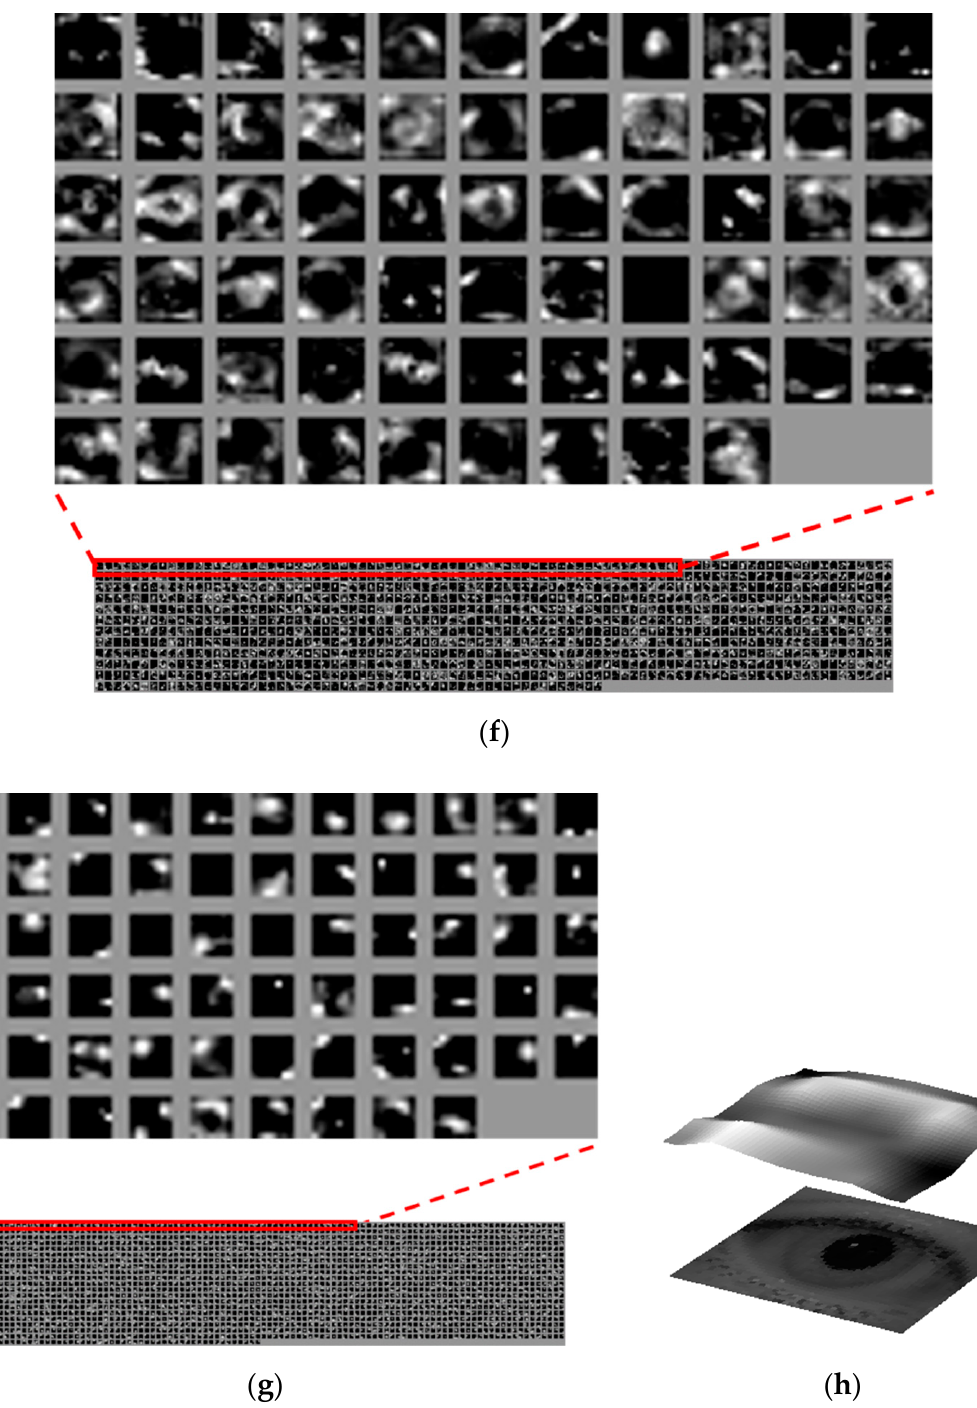
Figure 12. Examples of features maps extracted from each layer for the input ocular images. Feature maps from ( a ) Conv1 of Table 2, ( b – d ) the first, second, and third iterations of residual blocks in Conv2 of Table 2, respectively, and ( e – g ) the last residual blocks in Conv3, Conv4, and Conv5 of Table 2, respectively. ( h ) 3-dimensional feature map image that is obtained by averaging all the feature map values of ( g ).